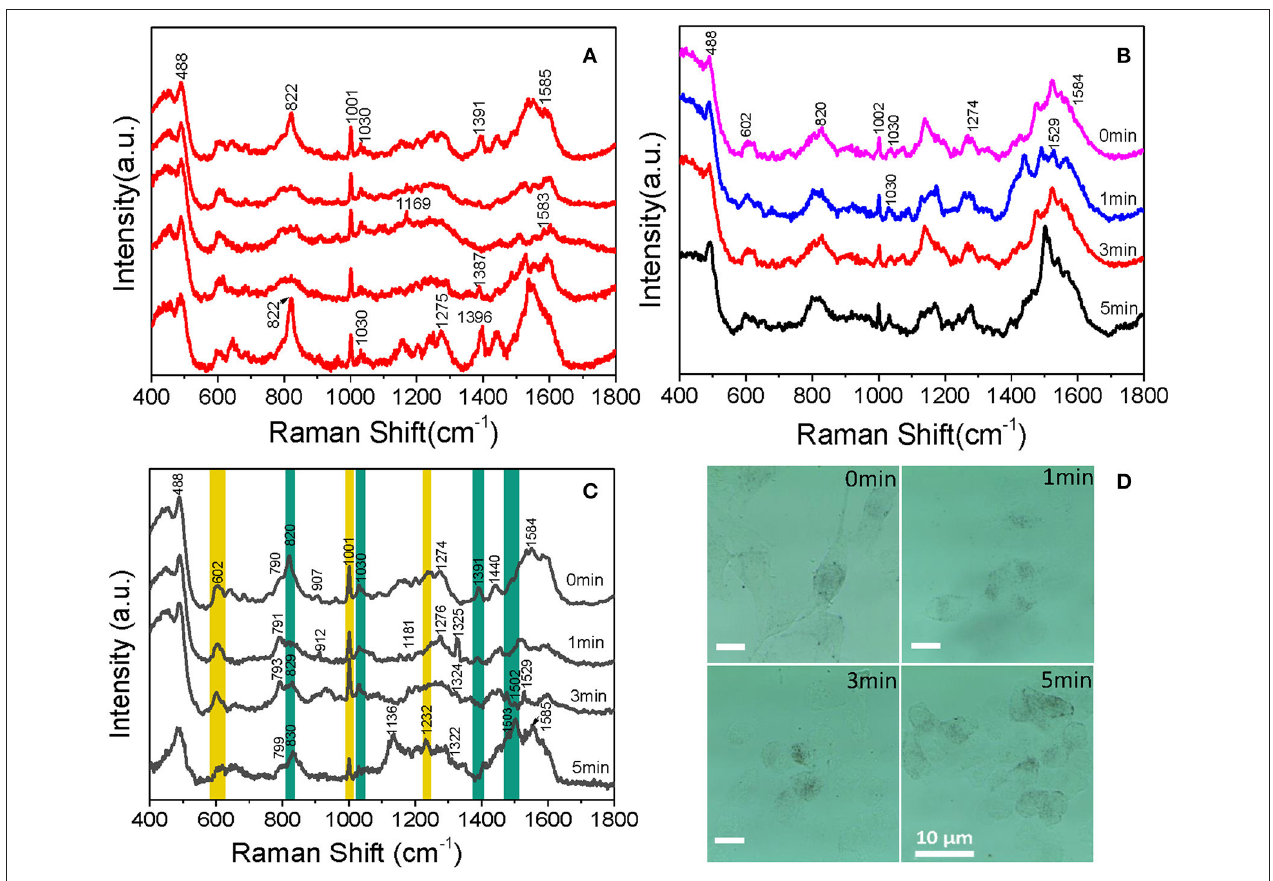
FIGURE 6 | Intranuclear SERS spectra of (A) five B16 cells cultured with 0.1nM AuNRs-PEG-NLS-RGD for 12h, (B) cells cultured with 0.1nM of AuNRs-PEG-NLS-RGD for 12h and then treated with 650nm LED (18 mW/cm 2 ) for 0, 1, 3, and 5min, respectively and (C) B16 cells cultured with 0.1nM AuNRs-PEG-NLS-RGD and 1.2 µ M Ce6 for 12h and then treated with 650nm LED (18 mW/cm 2 ) for 0, 1, 3, and 5min, respectively. (D) Bright-field images of B16 cells cultured with 0.1nM AuNRs-PEG-NLS-RGD and 1.2 µ M of Ce6 for 12h and then treated with 650nm LED (18 mW/cm 2 ) for 0, 1, 3, and 5min,